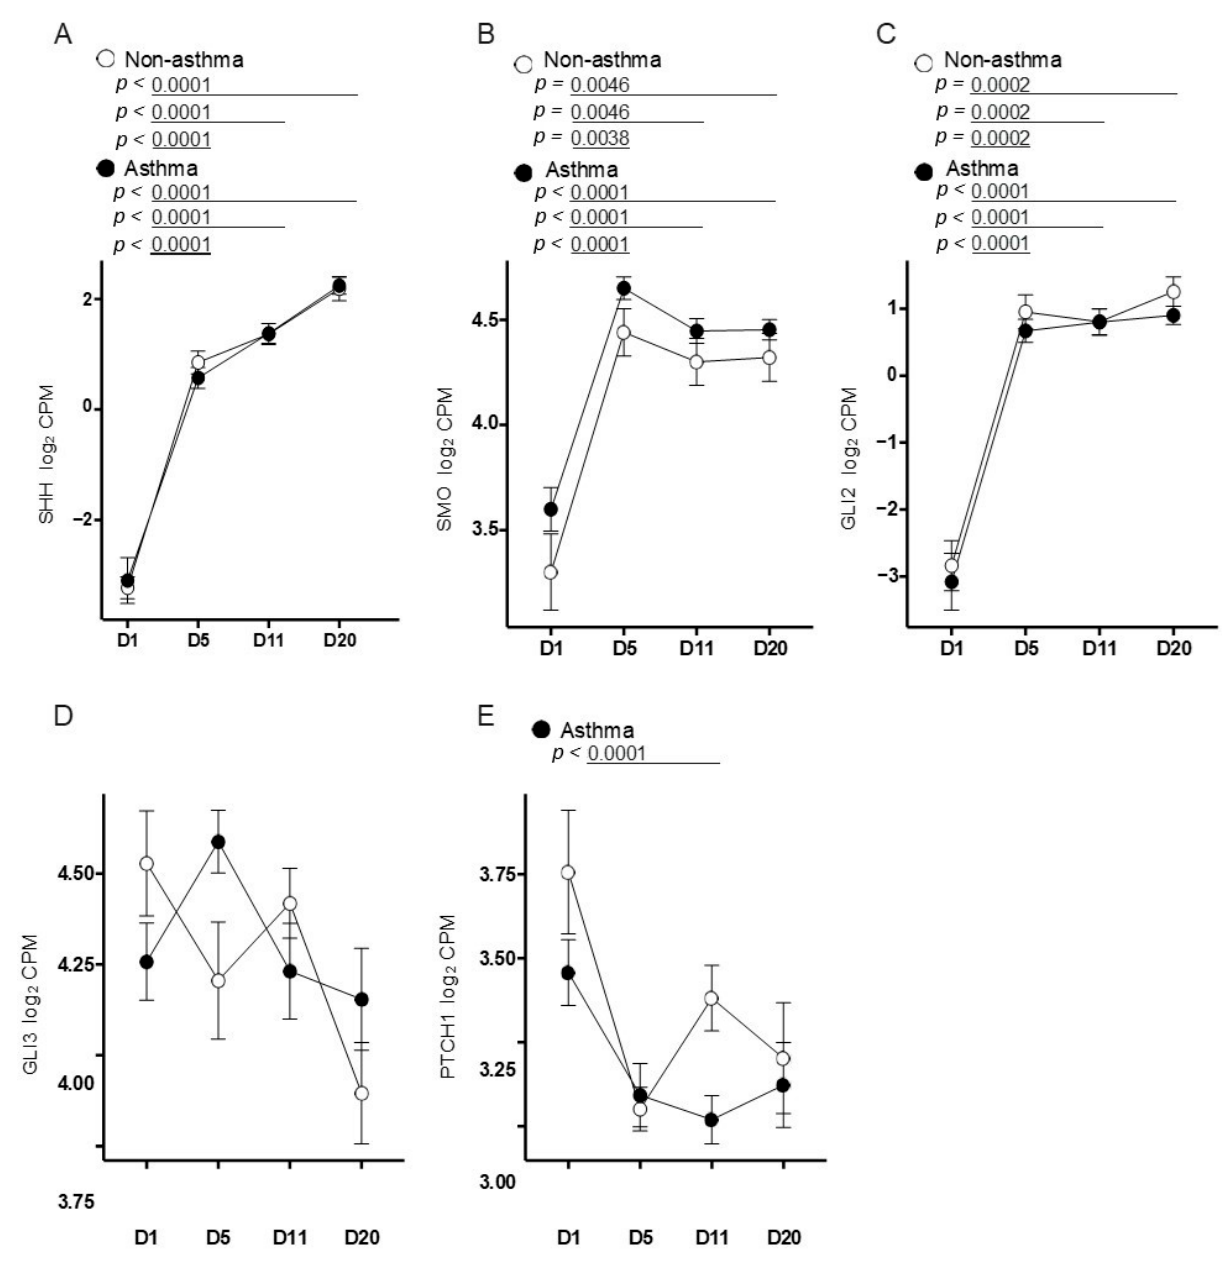
Figure 5. Hedgehog-signaling-related gene expression in differentiated air-liquid interface (ALI) cultures of primary airway epithelial cells. ( A ) SHH , ( B ) SMO , ( C ) GLI1 , ( C ) GLI2 , ( D ) GLI3 and ( E ) PTCH1 gene expression from non-asthmatics ( n = 5) and asthmatics ( n = 10) primary airway epithelial cells (PAECs) cultured for 1-, 5-, 11- or 20 days post-ALI were expressed as Reads Per Kilobase of transcript, per Million mapped reads (RPKM). One-way ANOVA with Dunnett’s multiple comparisons test was used in panels ( A – E ).